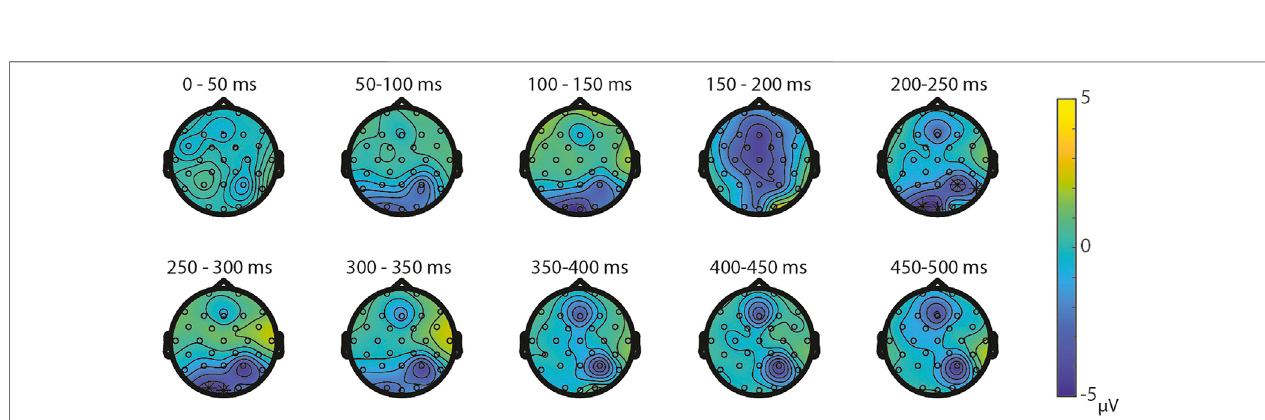
FIGURE6| Topoplotsofthedifferencesbetweensmallandlargesurfacepertimewindowwithasterisksrepresentingthesigni fi cantdifferencesbetweenthesmall and large surface based on α (cid:1) 0.05.